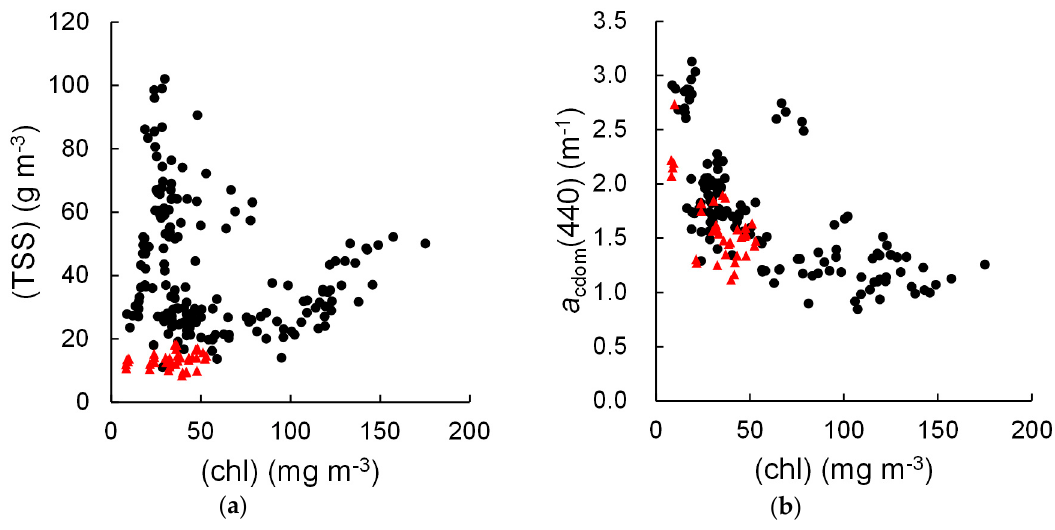
Figure 2. Scatterplots of measured ( a ) concentrations of total suspended sediments ((TSS)] and ( b ) concentrations of colored dissolved organic matter ( a cdom (440)) versus chlorophyll concentrations ((chl)) for samples in the Wabash River (circles) and the Tippecanoe River (triangles) in summer 2014.